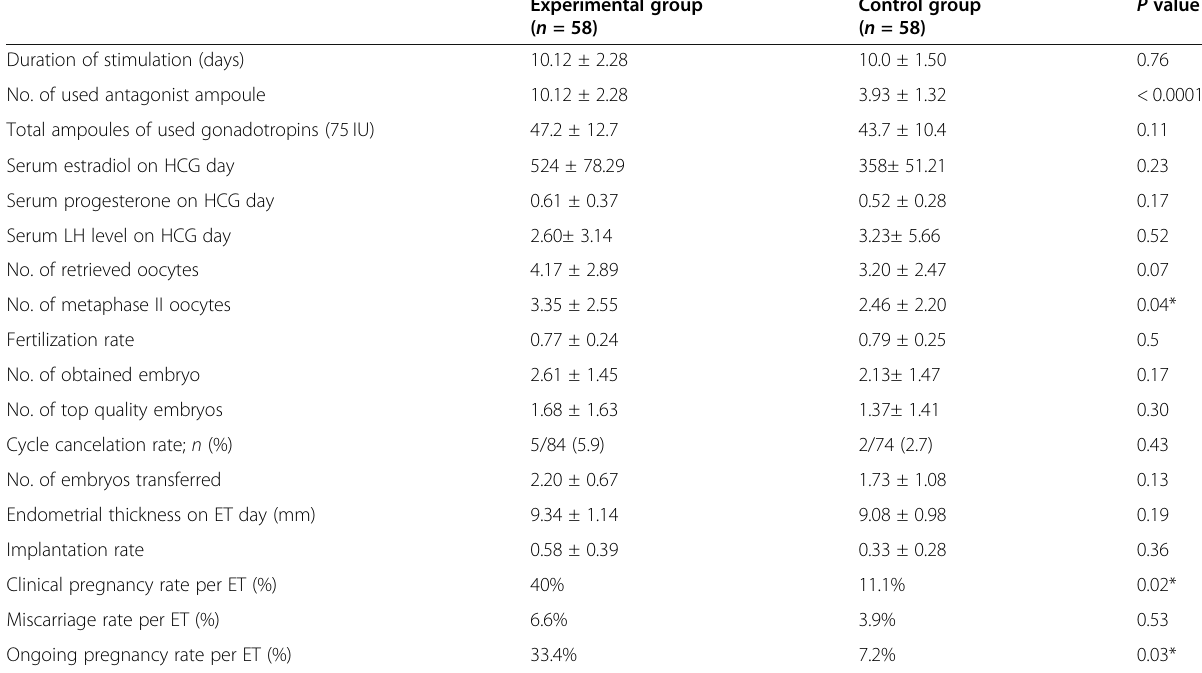
Table 2 Comparison of the cycle and pregnancy outcomes between groups